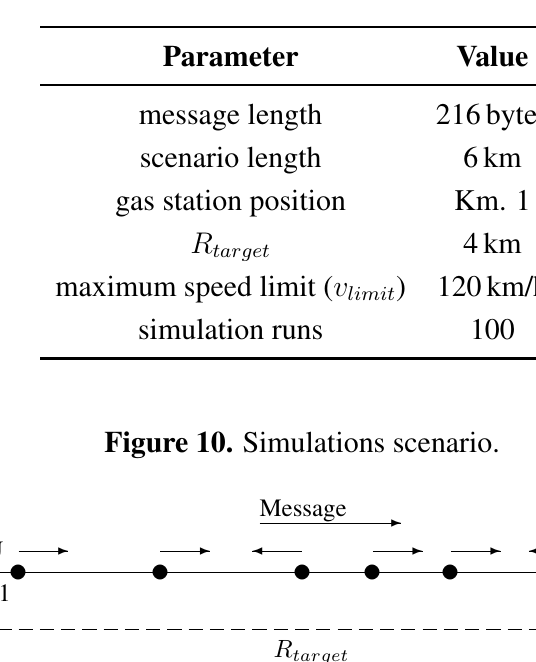
Table 3. General simulation settings.